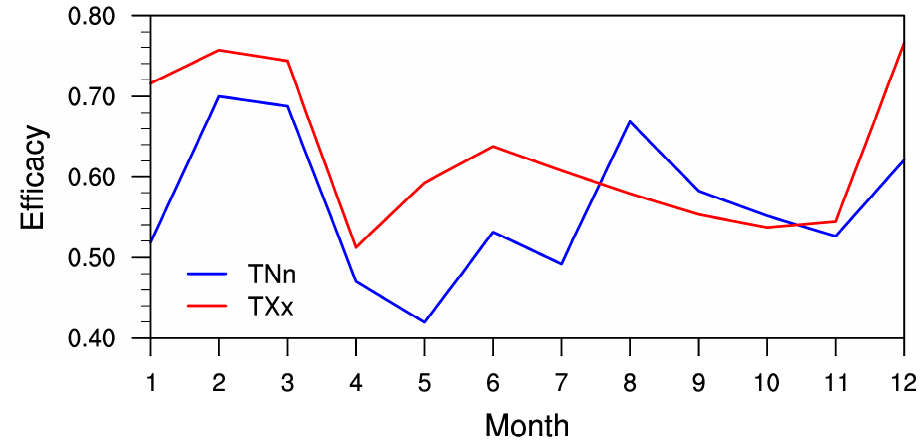
Figure 10. Timeseries of monthly efficacy of the G4cdnc experiment for neutralizing extreme (TNn and TXx) temperatures during the progress period (2060–2069) in RCP4.5 over East Asia. Results are shown for multi‐model ensemble mean.